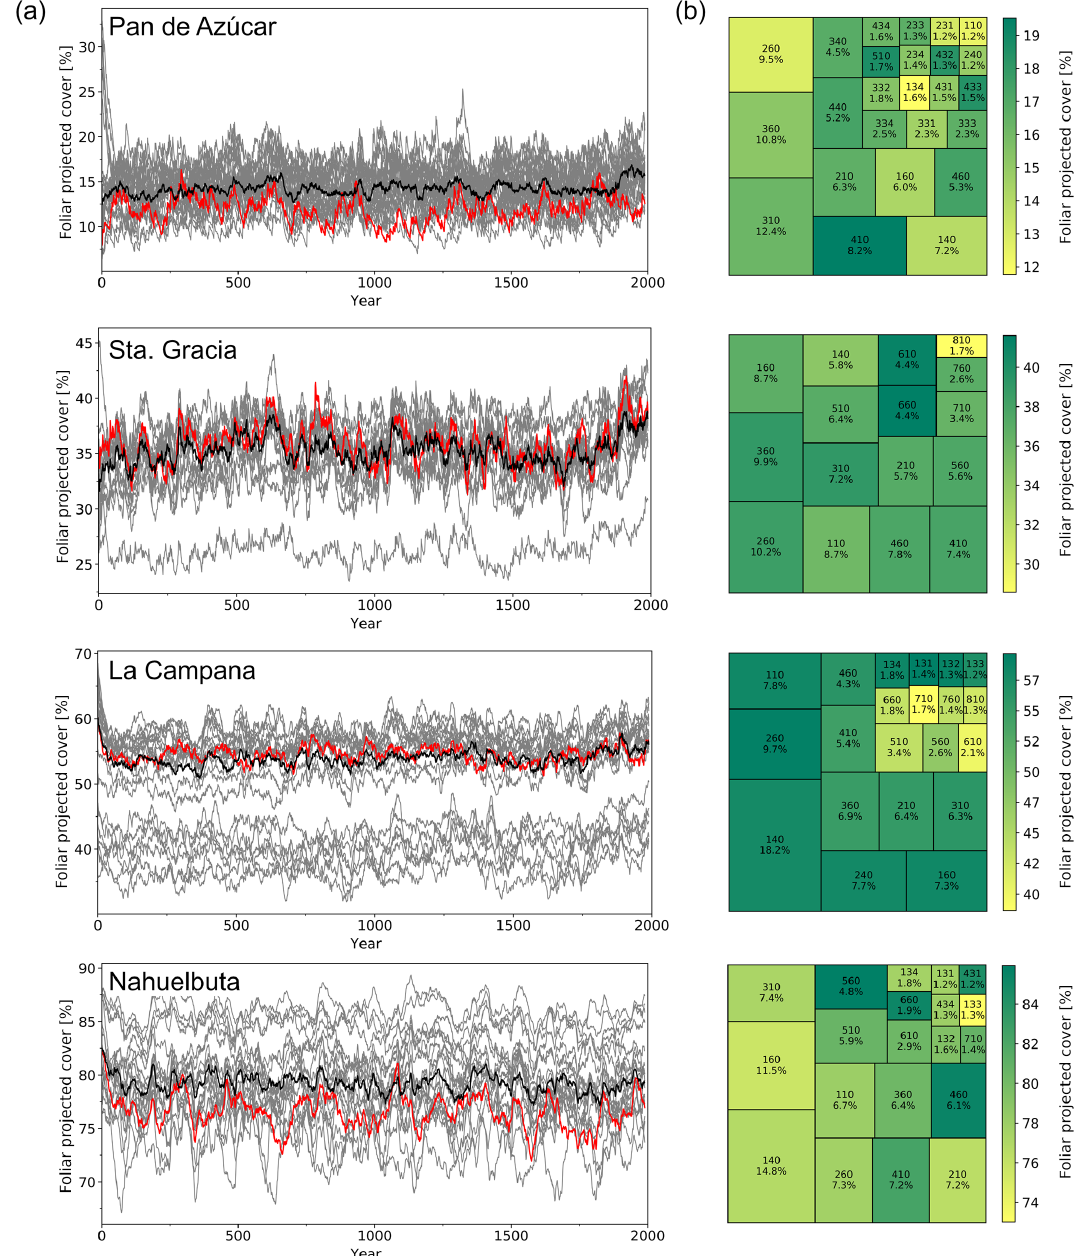
Figure B2. (a) Change of foliar projected cover for the individual landforms (gray), the area-weighted mean of all landforms (black), and the default LPJ-GUESS setup with no landforms (red) for the last 2000 years of the transient simulations. (b) Areal extent and foliar projected cover of the individual landforms in the four simulated grid cells (averaged for the last 100 years of the time series; text: landform ID code and percentage of the total grid cell covered by this